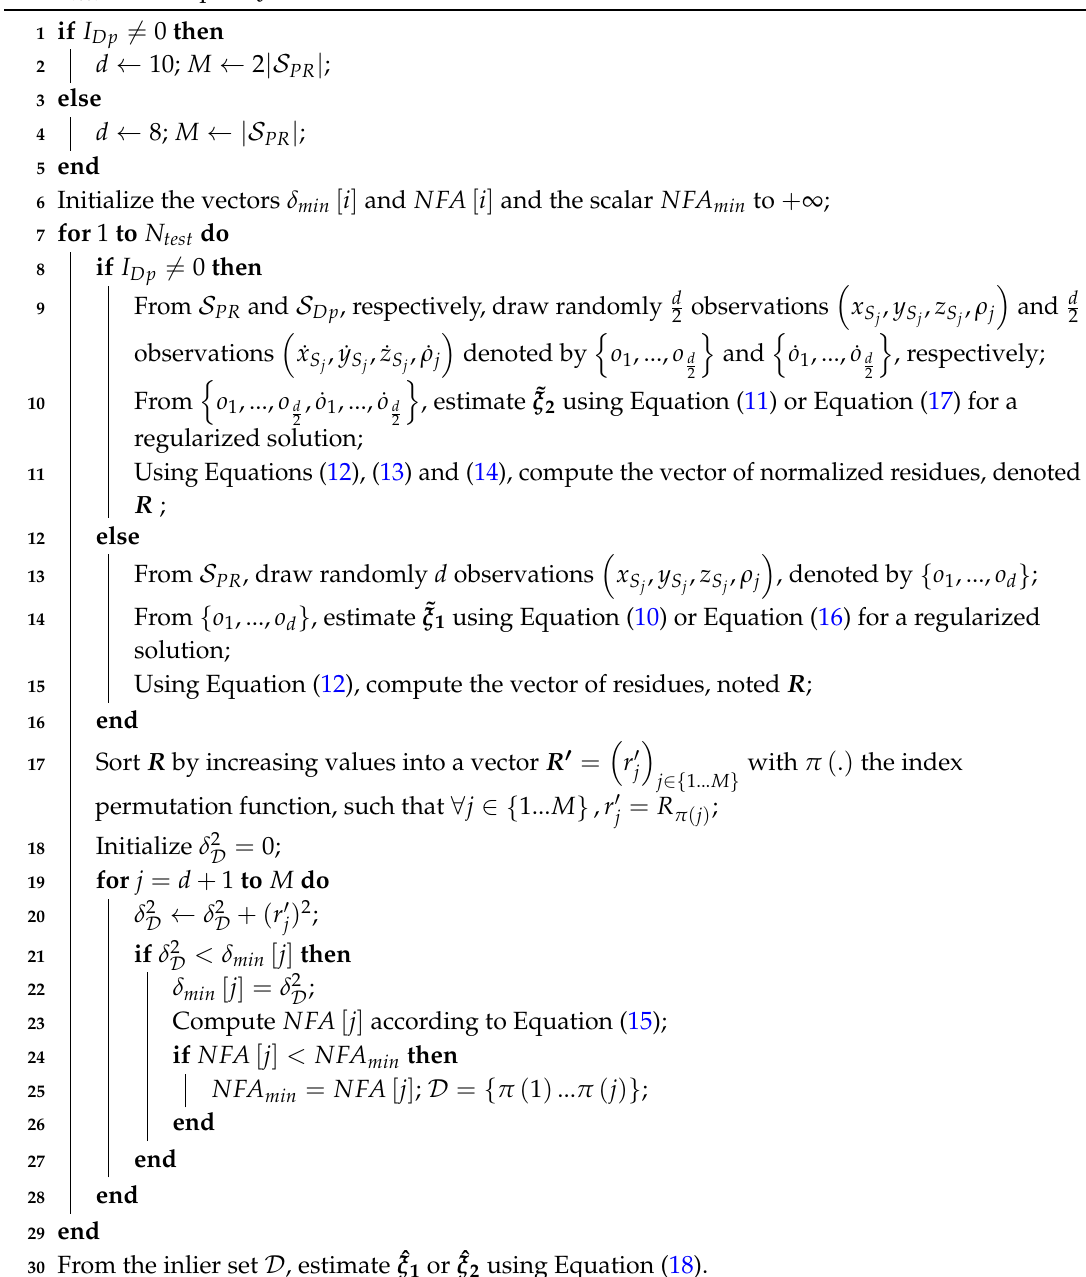
Algorithm 1: ˜ ξ i Estimation Based on the NFA Criterion with Inputs S PR , S Dp , σ , σ PR , σ Dp , I Dp , t , N test and Outputs ˜ ξ and D